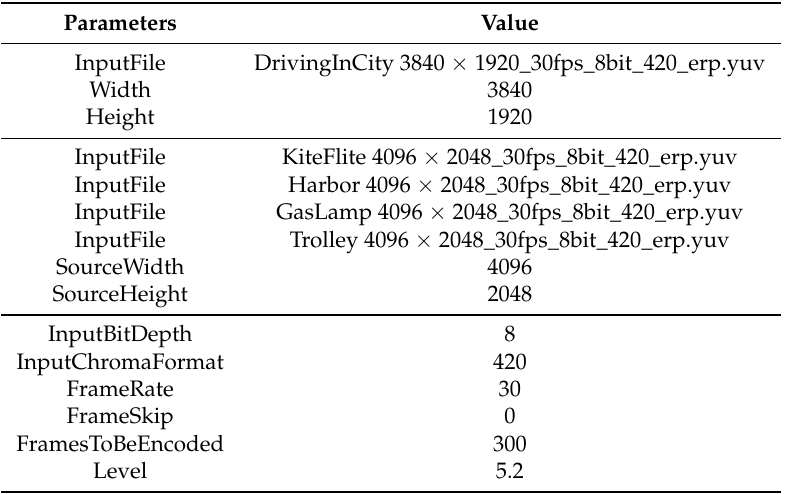
Table 1. The 360 videos bitstreams by